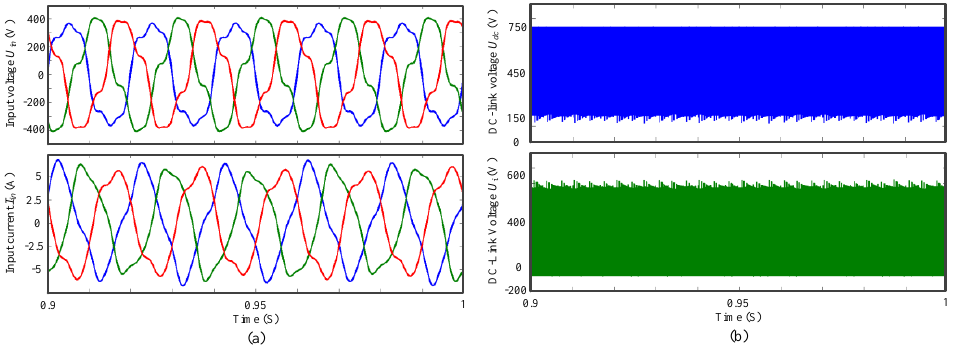
Figure 11. Input ( a ) distorted-grid voltage and current; ( b ) distorted supplied for DC-link voltage after and before Z-source.